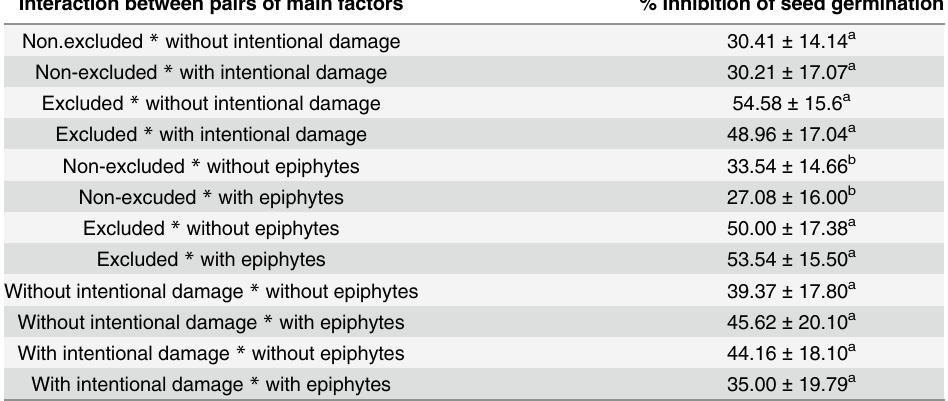
Table 2. Mean ( ± SE) of the percentage of inhibition of the germination of T . recurvata seeds in response to the application of dichloromethane extracts obtained from branches of I . murucoides . The data refer the interaction between pairs of the main factors of the experiment: exclusion (excluded vs . non-excluded branches), intentional damage (branches with intentional damage vs . branches without inten- tional damage) and with the presence/absence of T . recurvata (N = 48). Within each section of the table, dif- ferent letters indicate statistical differences between the interaction of the pairs of treatments (Tukey test P <